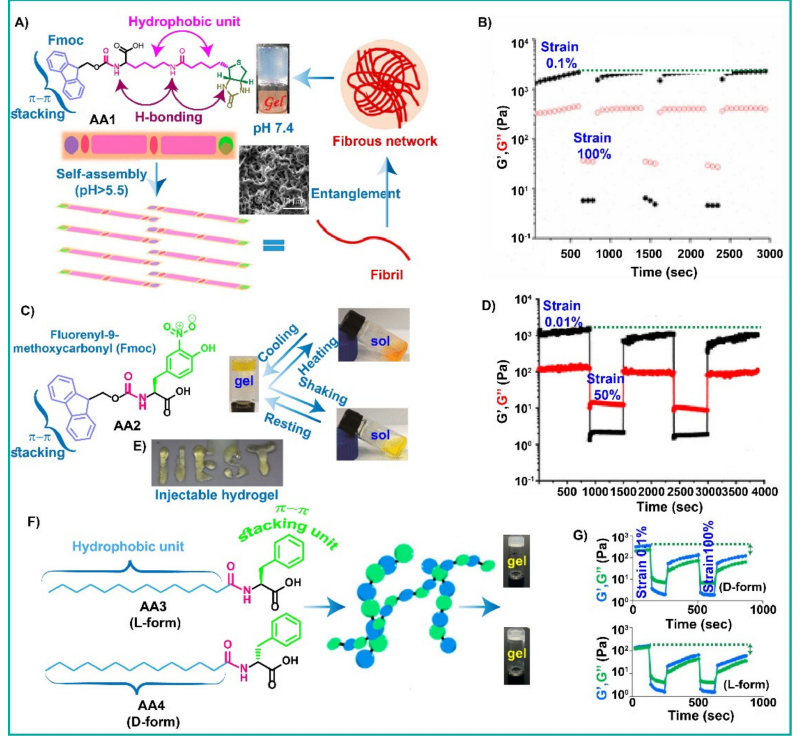
Figure 1. ( A ) Chemical structure of the hydrogelator (AA1) and possible self-assembly schematic. ( B ) Thixotropy test of AA1 hydrogel; reproduced with permission from Ref. [54]. Copyright (2018) American Chemical Society. ( C ) Chemical structure and stimuli-responsive behavior of the AA2 gelator. ( D ) Rheology experiment confirming the thixotropic behavior of AA2. ( E ) Injectability behavior of AA2; reprinted with permission from Ref. [61]. Copyright (2019) American Chemical Society. ( F ) Self-assembly and hydrogel formation of amino acids, AA3 and AA4. ( G ) Shear-recovery cycle of AA3 and AA4; reproduced with permission from Ref. [62]. Copyright (2019)